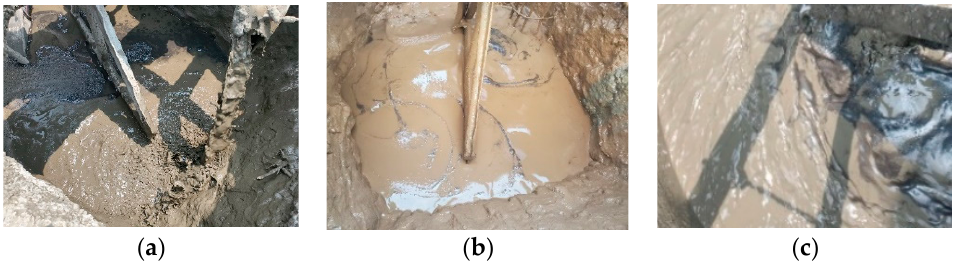
Figure 15. On-site mixing of modified cement grouting materials. ( a ) HPCG. ( b ) RPCG. ( c ) MKCG.